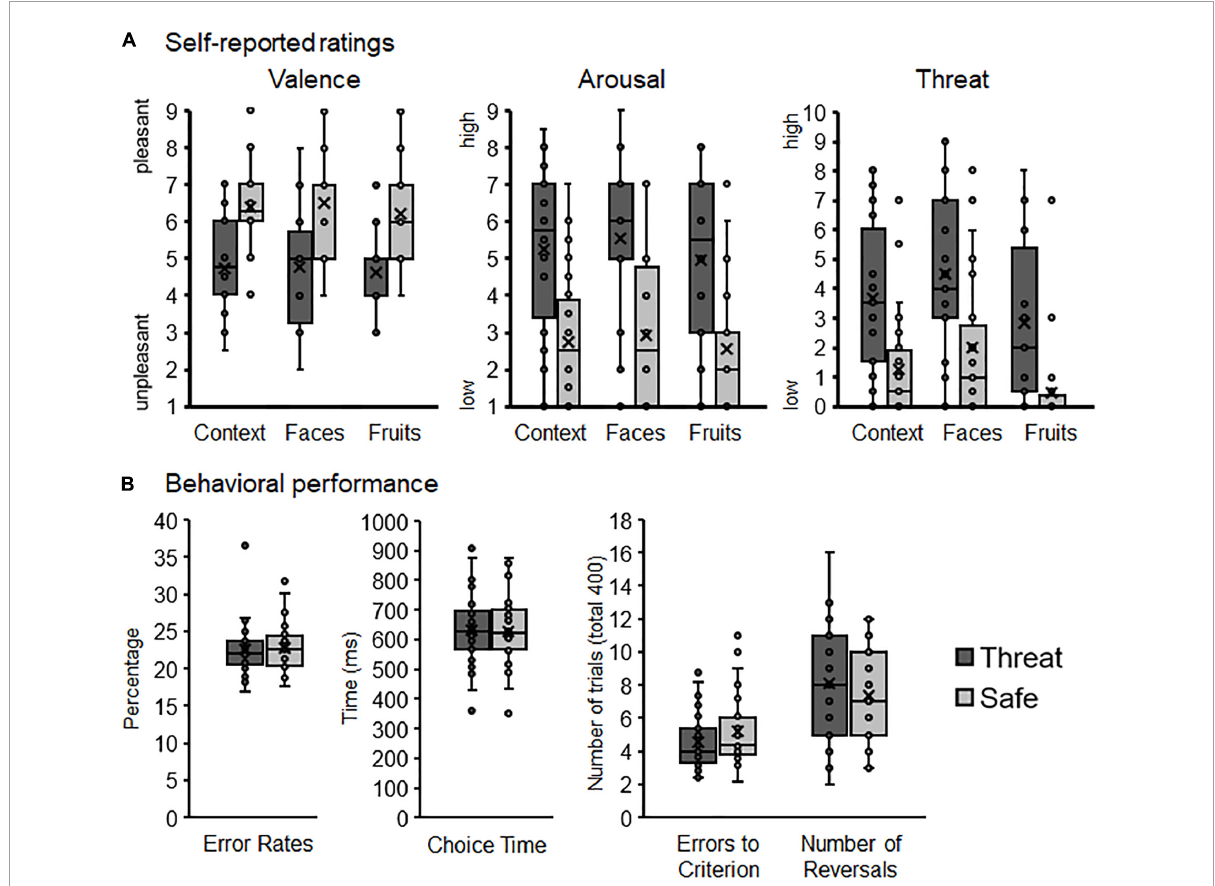
FIGURE2 Rating and behavioral data illustrated with boxplots (median, first and third quartiles, and outliers). (A) Self-reported valence, arousal, and threat ratings for context conditions, faces, and fruits. (B) Behavioral performance measures illustrating error rates, choice times, errors to reach learning criterion, and number of reversals as a function of contextual threat and